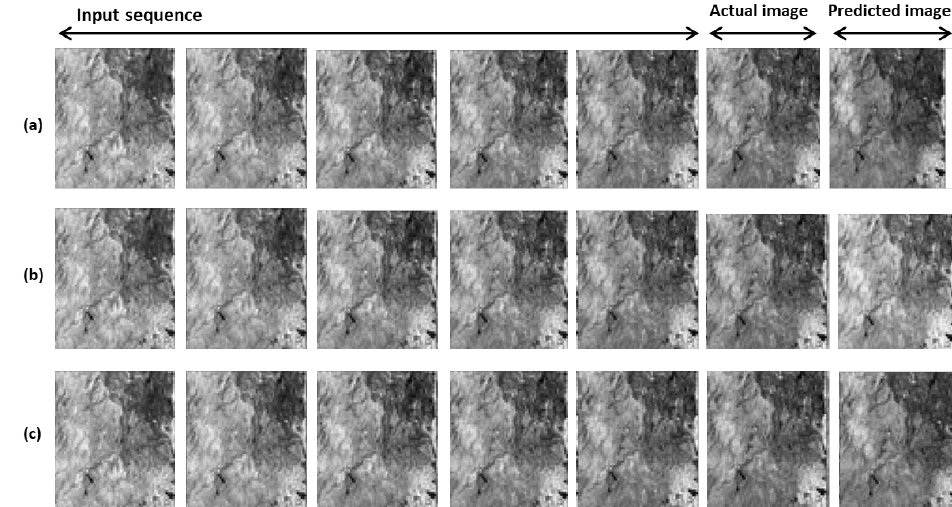
Figure 9. Prediction results obtained for BNP with: ( a ) CNN-LSTM model; ( b ) ConvLSTM model; ( c ) Stack-LSTM model. timestep = 5.